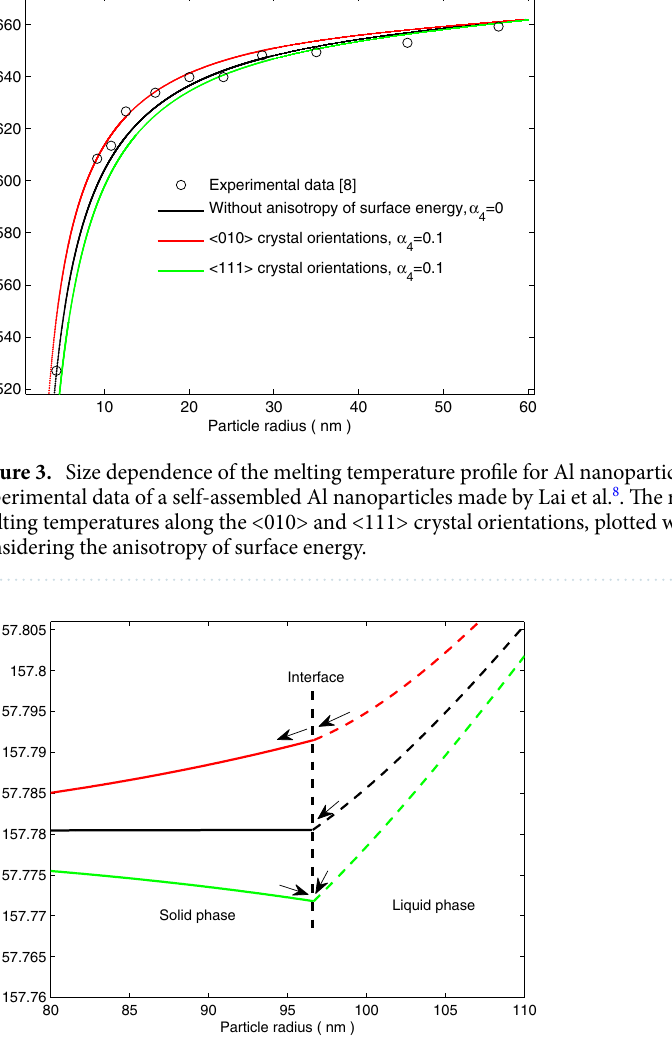
Figure 4. Temperature distributions of indium nanoparticle in the liquid phase (dashed lines) and the solid phase (solid lines) near the interface (vertical dashed line) along the < 010> (red lines) and <111> (green lines) crystal orientations. By contrast, the black solid and dashed lines denote the temperature distribution without the anisotropy of surface energy in the asymptotic solution (17). The arrows represent the heat flux